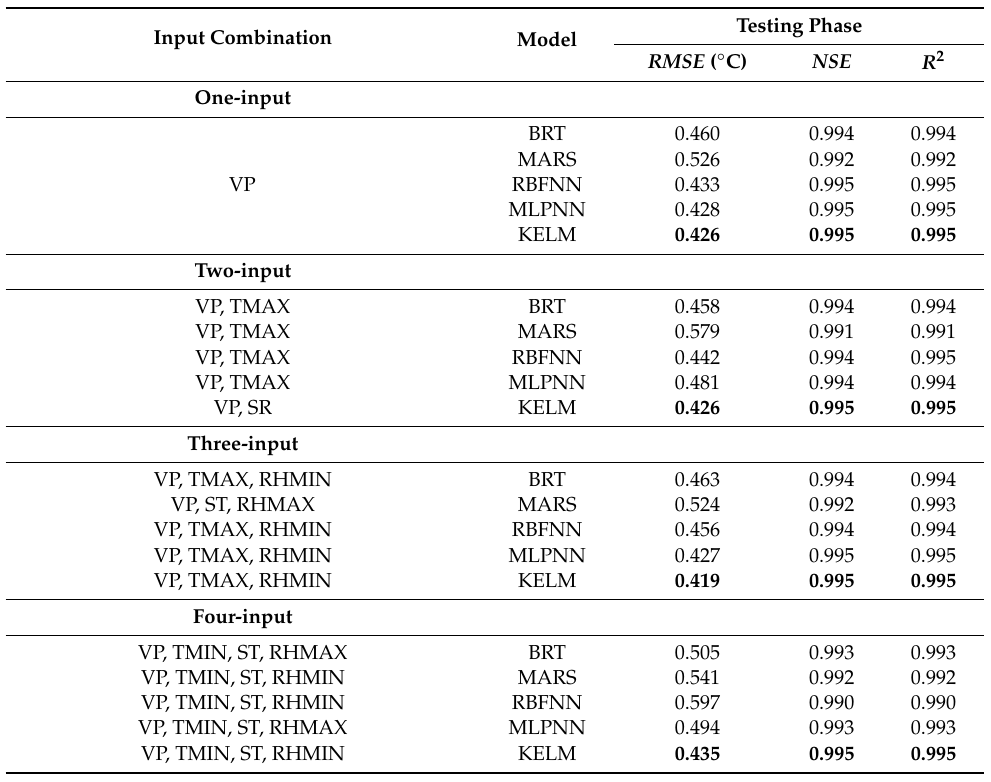
Table 3. Results of the best BRT, MARS, RBFNN, MLPNN, and KELM models for estimating daily T dew at Durham